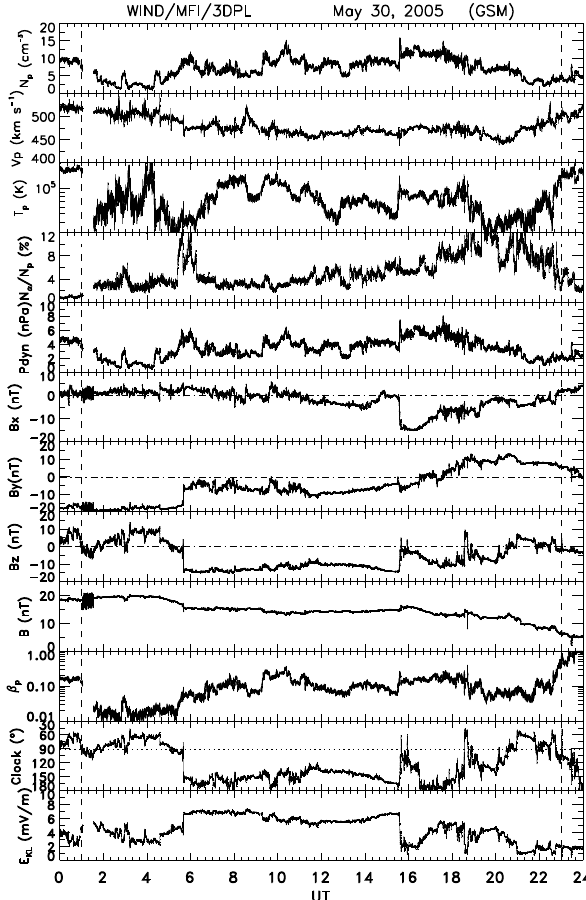
Fig. 1. Interplanetary data from spacecraft Wind on 30 May 2005. Panels from top to bottom shows proton density, bulk speed, proton temperature, alpha/proton number density ratio, dynamic pressure, magnetic field components B x , B y , and B z (GSM coordinates), the total field, plasma beta, clock angle of the B -field, and the reconnec- tion electric field E KL . The ICME interval from 01:00 to 23:00UT is delimited by the vertical dashed